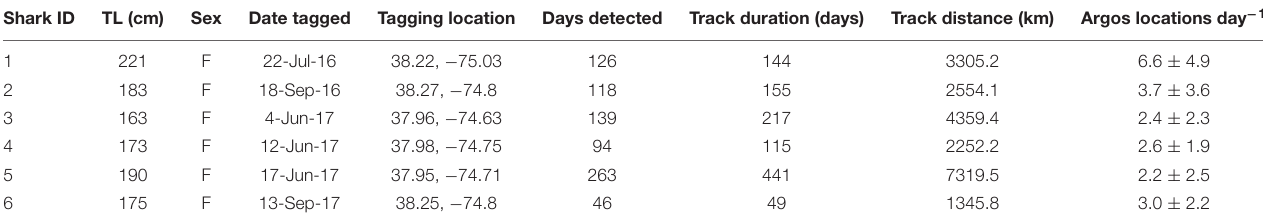
TABLE 1 | Summary information for SPOT tag deployments on juvenile smooth hammerhead sharks. Shark ID TL